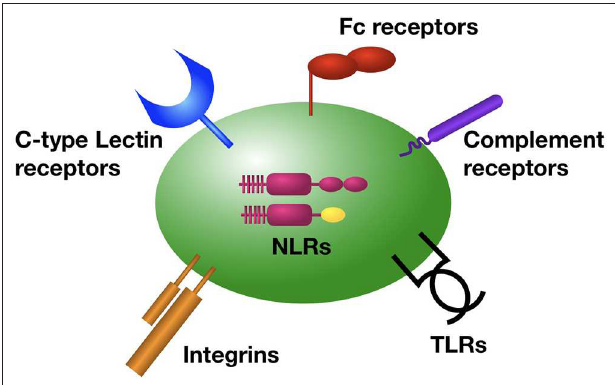
FIGURE 1 | Platelet receptors for the detection of bacterial pathogens in the bloodstream. Platelets are equipped with a diverse array of surface and intracellular receptors for pathogen detection, enabling their function as intravascular sentinel cells. These include receptors for the detection of bacterial produces and molecules (TLRs, NLRs, C-type lectins, integrins, GP1b α ), as well as bacteria that have been coated by antibody (Fc recpetors), complement (complement receptors), or von Willibrand factor (integrins and GP1b α